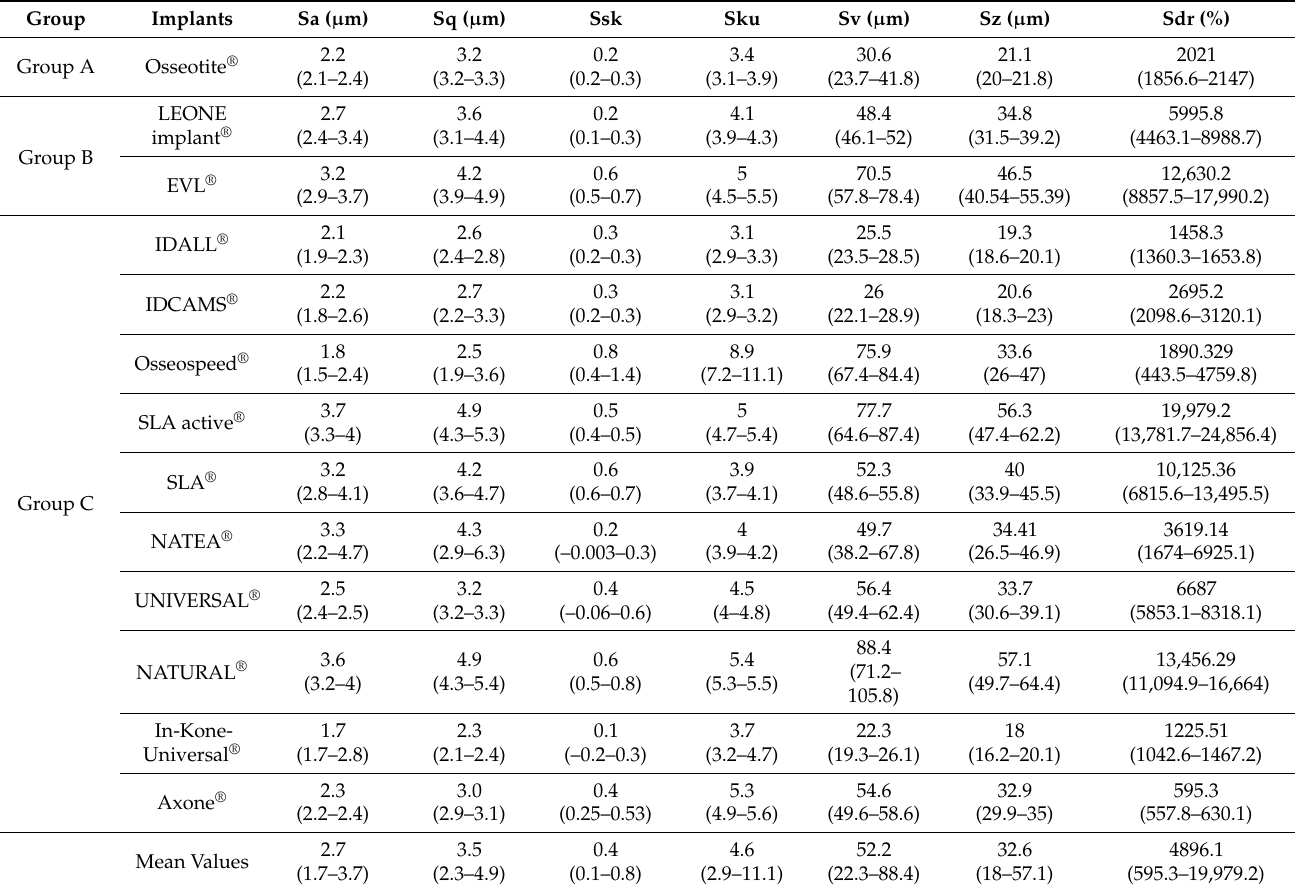
Table 2. Results of the roughness parameters analyzed